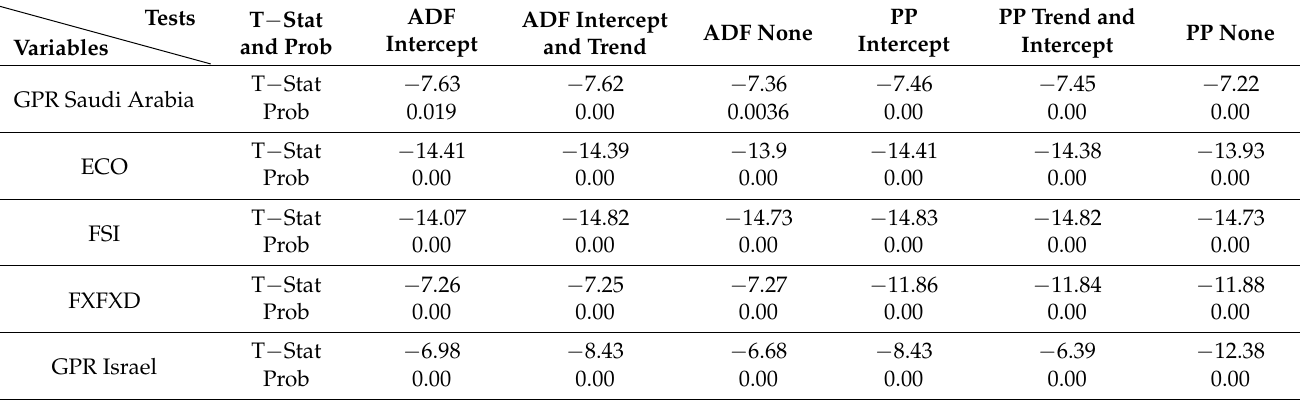
Table 4. Stationarity test: Augmented Dickey Fuller (ADF) and Phillips–Perron (PP).